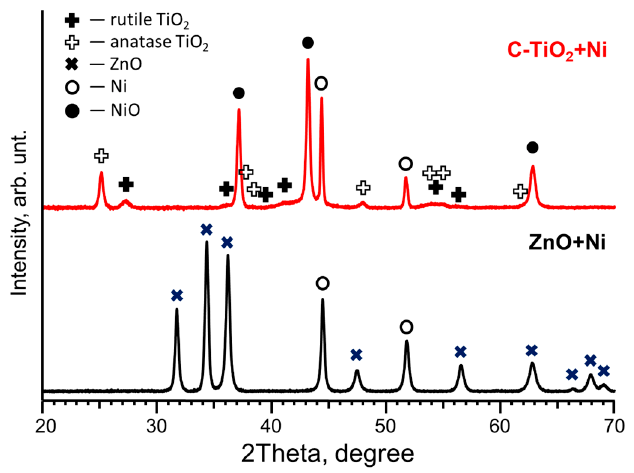
Figure 2. XRD patterns of C-TiO 2 +Ni (red) and ZnO+Ni (black) MP powder.